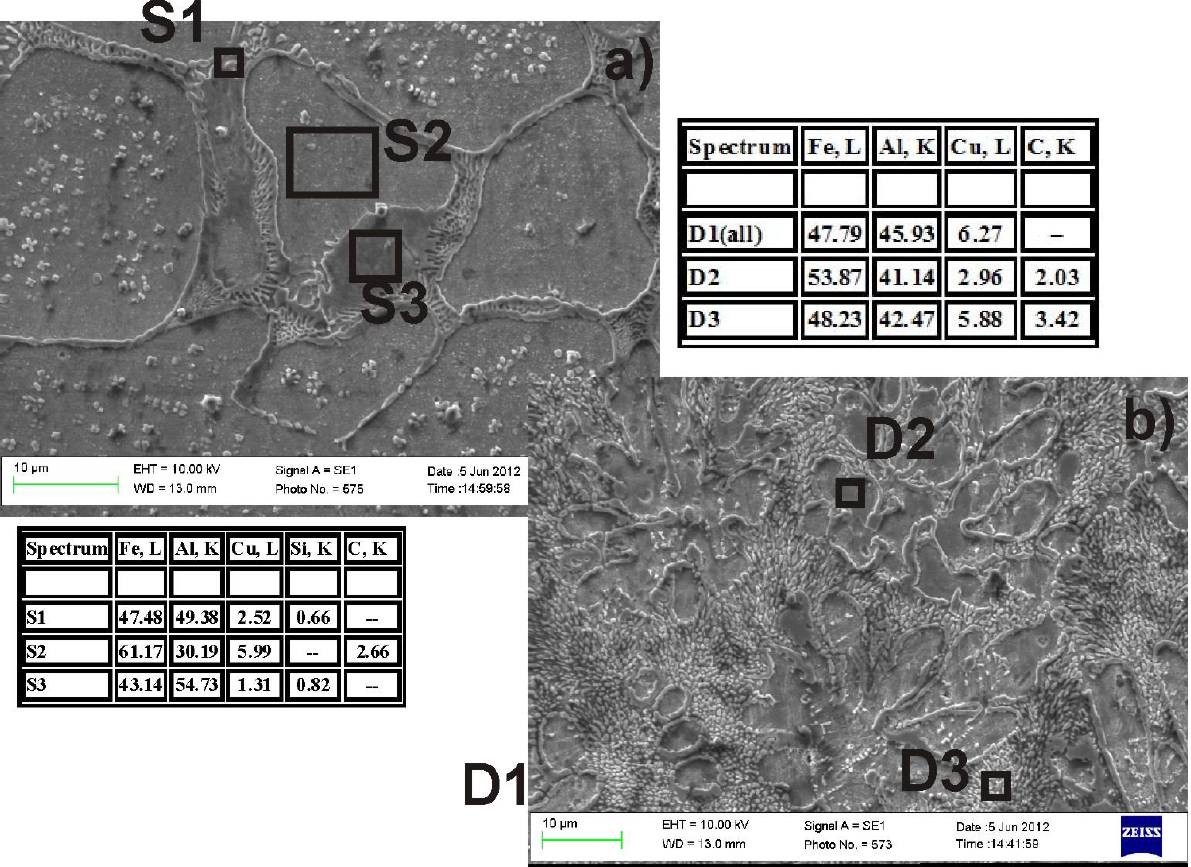
Figure 6. SEM micrographs showing typical solidification microstructures of the middle